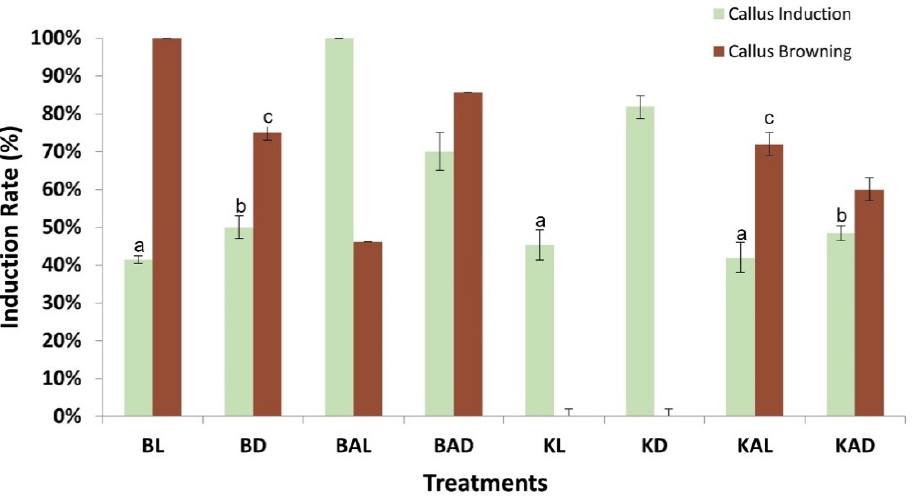
Figure 1. Evaluation of conditions affecting oregano callus induction from leaf explants and callus browning rate. B = MS + 0.5 mg/L 2,4 D + 3 mg/L BAP, K = MS + 2 mg/L 2,4 D + 2 mg/L Kin, A = ascorbic acid (10 mg/mL), L = 16 light, D = constant dark. Letters (a, b, c) indicate no statistical difference in callus induction among treatments.